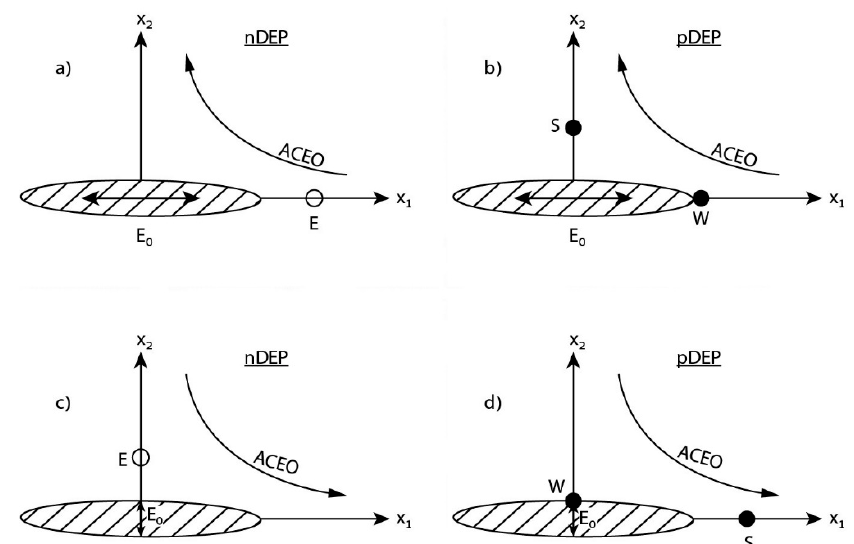
Figure 4. Four scenarios describing stable (S) and equilibrium (E) saddle-like trapping points in the fluid as well as stable wall (W) stagnation trapping for different orientations of the ambient AC electric field and sign of the Clausius Mossotti (CM) coefficient of a free